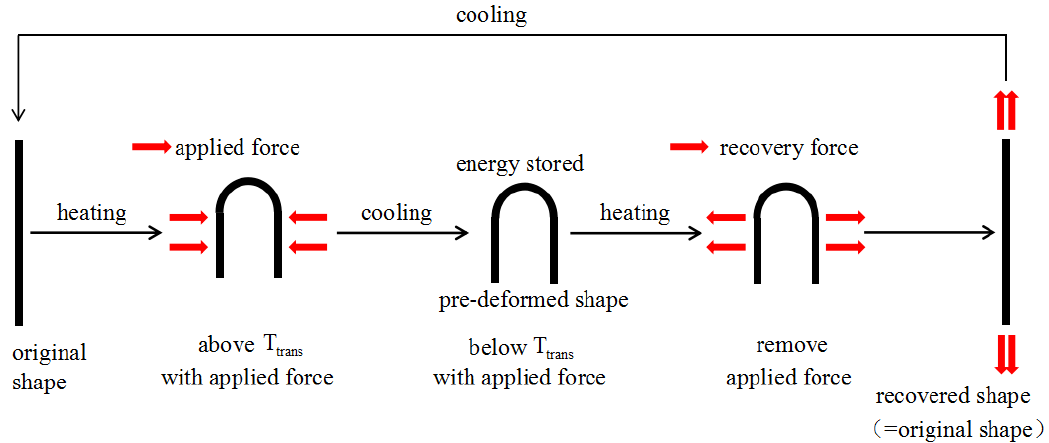
Figure 1. A schematic diagram of the thermal deformation process of shape memory epoxy polymer (SMEP).